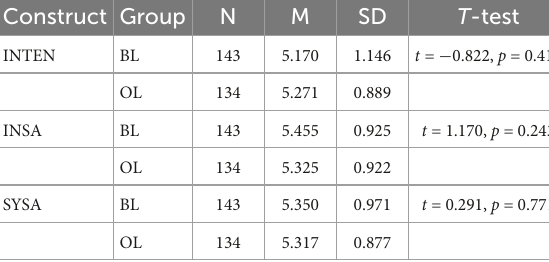
TABLE 5 The two groups were analyzed by T -test in intention, information satisfaction and system satisfaction. Construct